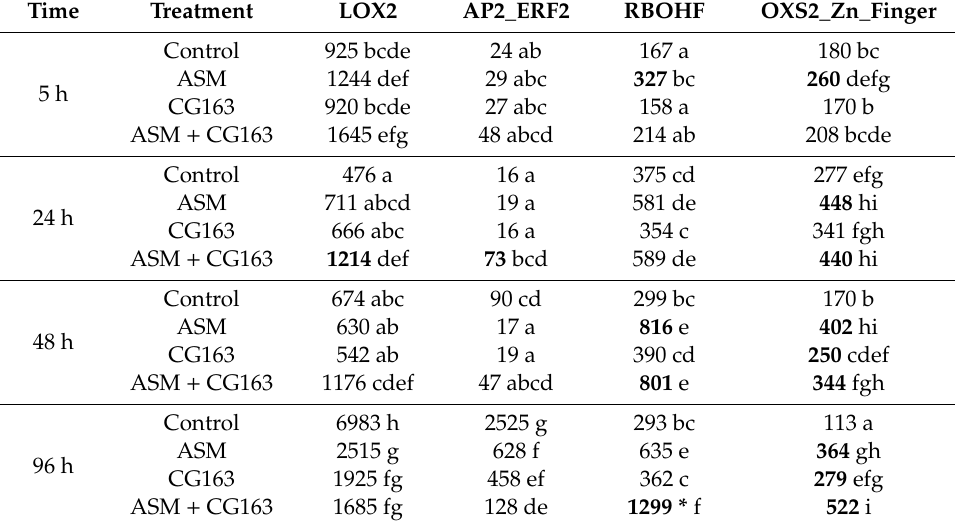
Table 2. Expression of lipoxygenase 2 (LOX2), APETALA2 ethylene responsive factor 2 (AP2_ERF2), respiratory burst oxidase homolog gene F (RBOHF) and oxidative stress 2 zinc finger (OXS2_Zn_finger) genes in Actinidia chinensis var. deliciosa ‘Hayward’ kiwifruit treated with a single foliar spray of acibenzolar-S-methyl (ASM), Aureobasidium pullulans isolate CG163 (CG163), combination of ASM and CG163 (ASM + CG163) or untreated (control). This was followed by spray inoculation with 2 × 10 7 CFU / mL Pseudomonas syringae pv. actinidiae 7 days after treatment, and sampling of leaf tissue 5, 24, 48 and 96 h after inoculation. Gene expression was measured by CodeSet